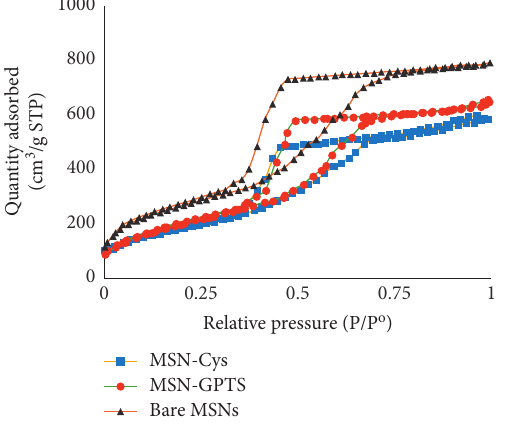
Figure 3: Nitrogen adsorption isotherms of bare MSNs ( ▲ black), MSN-GPTS ( ● red), and MSN-Cys ( ■ blue). Table 1: Physiochemical data obtained for bare MSNs, MSN-GPTS, and MSN-Cys.